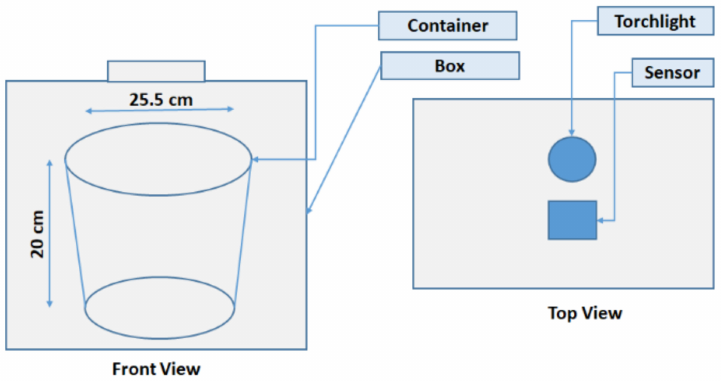
Figure 4. The experimental design to set up the shrimp counting system.